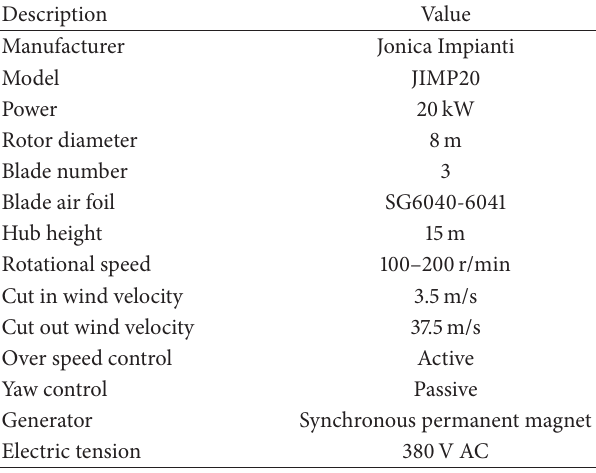
Table 1: Main wind turbine characteristics.